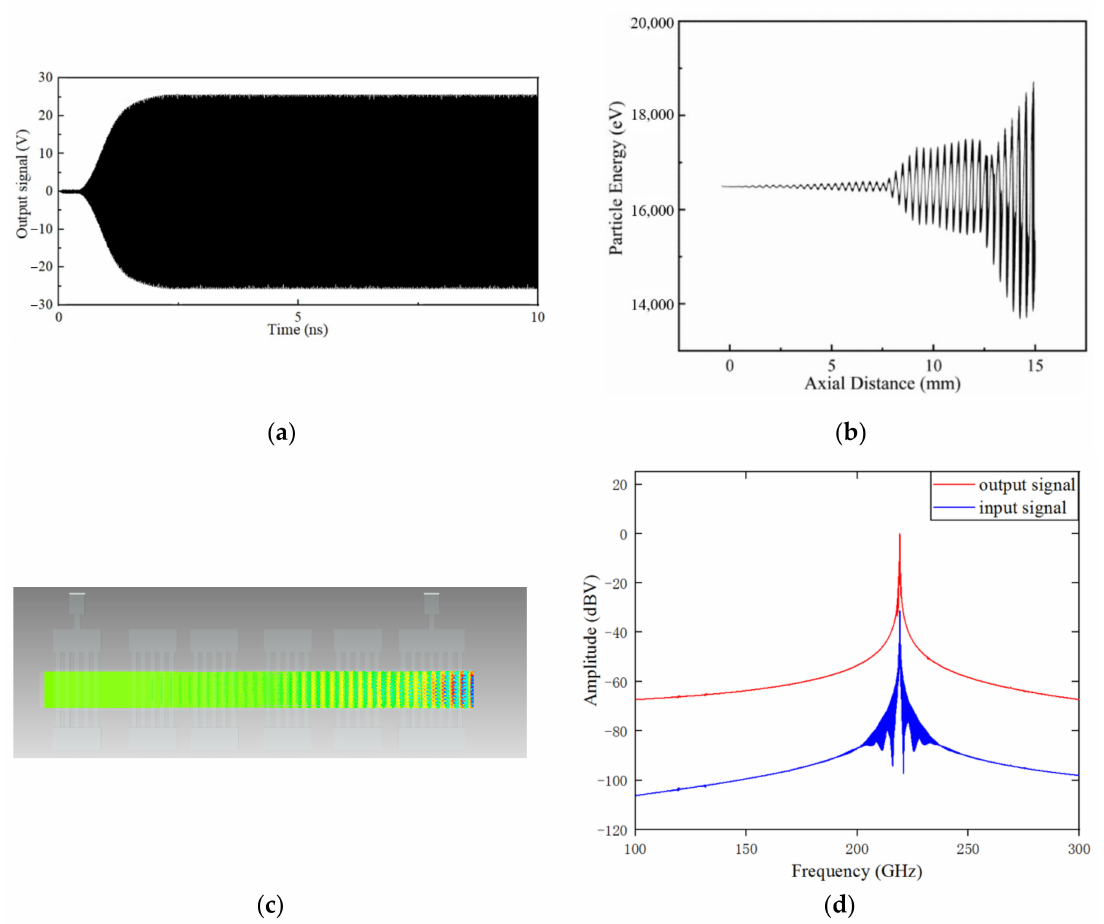
Figure 7. Output characteristics of the EIK at a frequency of 218.9 GHz: ( a ) Output signal versus time; ( b ) phase space portrait of the particle energy distribution; ( c ) beam bunching sketch; and ( d ) frequency spectrum of the input and output